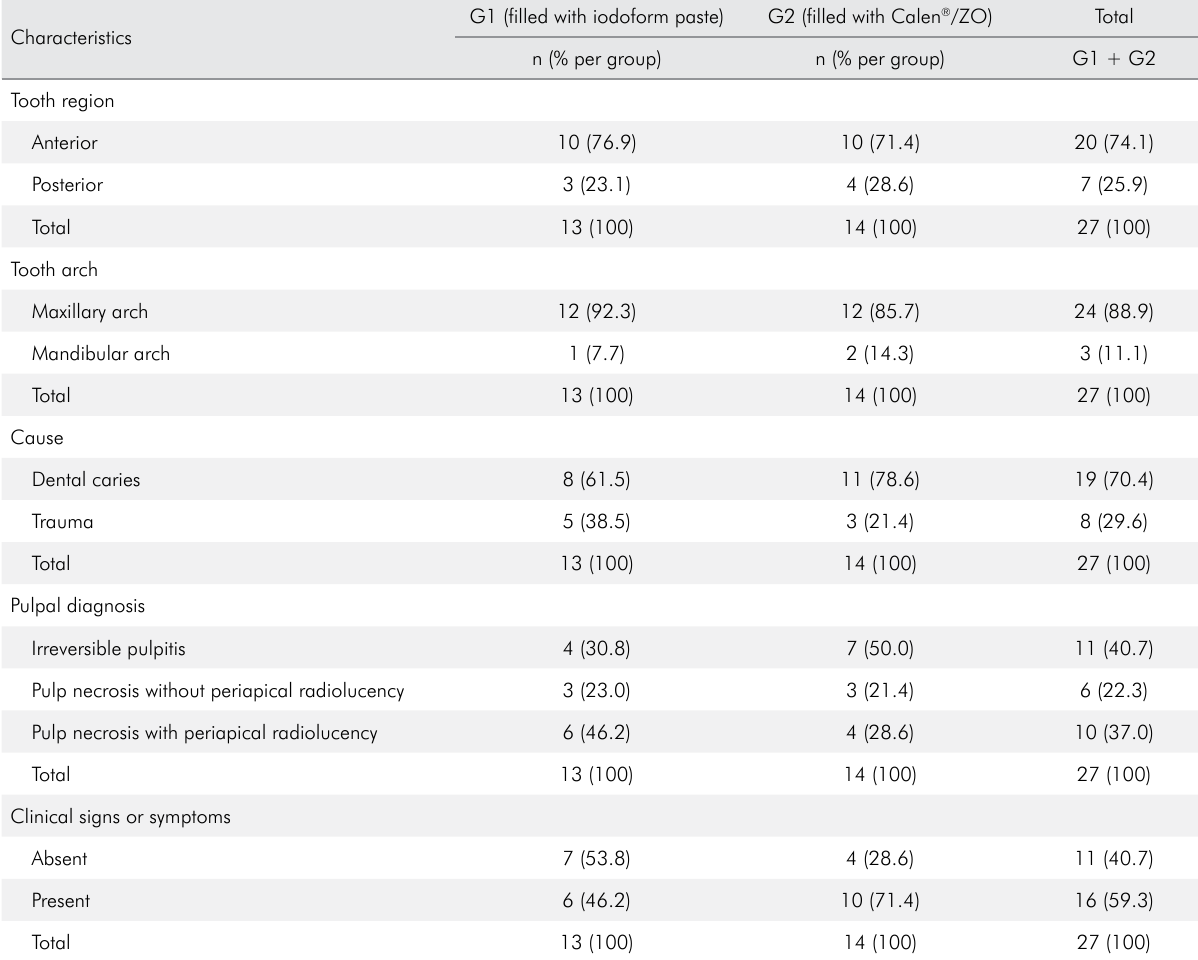
Table 1. Baseline characteristics of the sample for each group (n = 27).